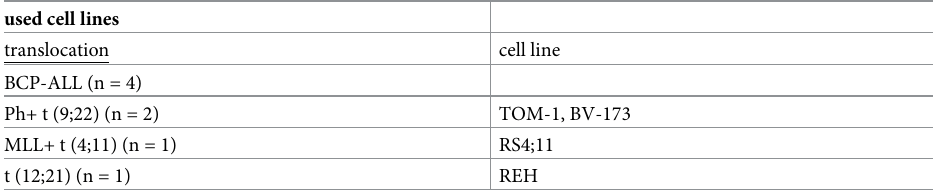
Table 1. Characteristics and name of the used BCP-ALL cell